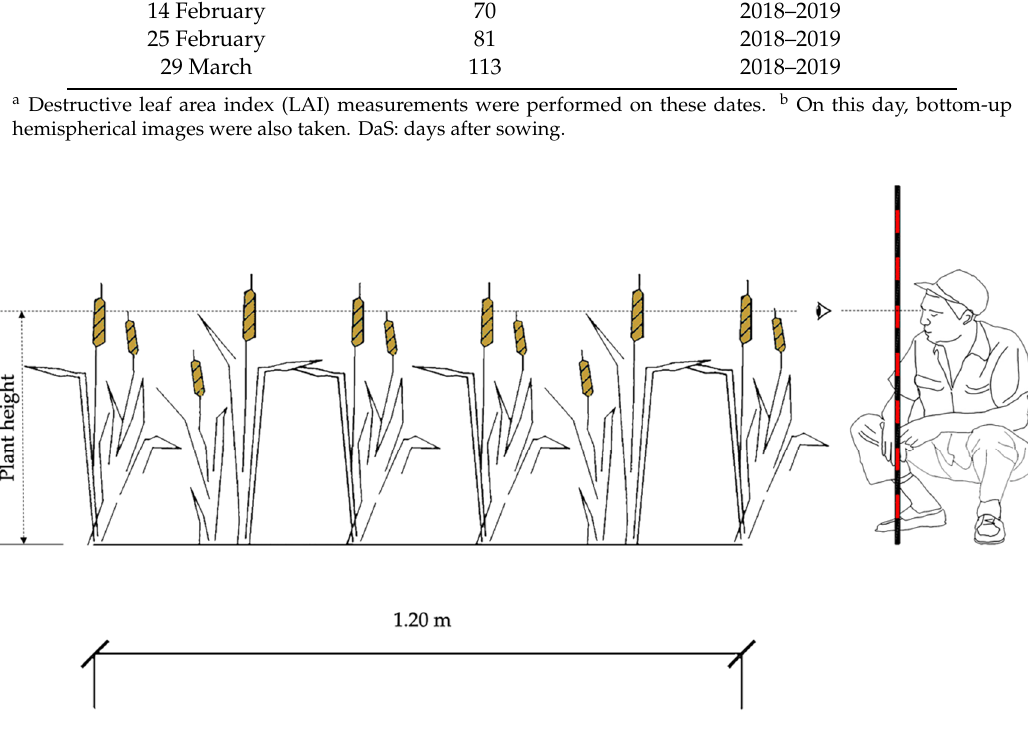
Figure 3. Methodology for measuring plant height.